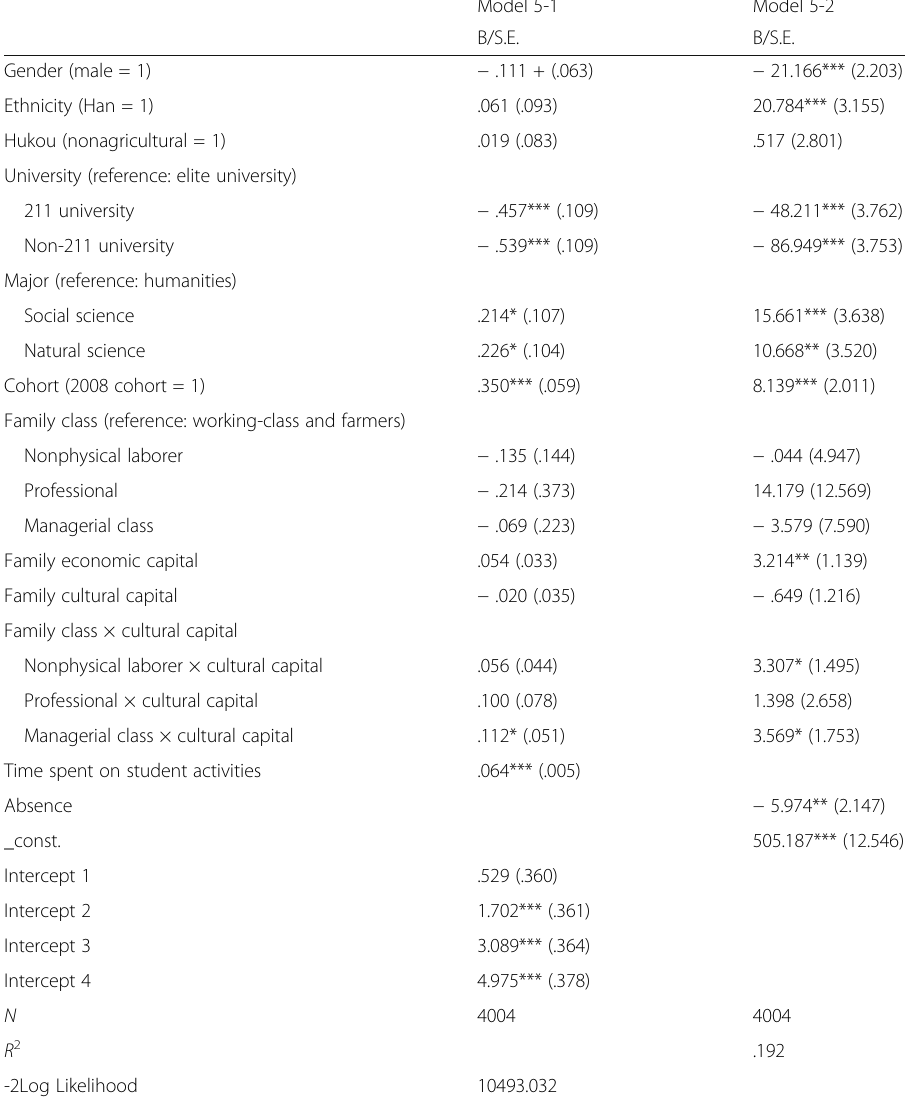
Table 5 Class difference in the effect of cultural capital